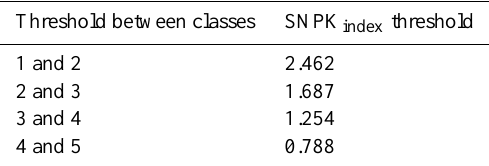
Table 5. Best-splitting SNPK index thresholds to classify profiles in five